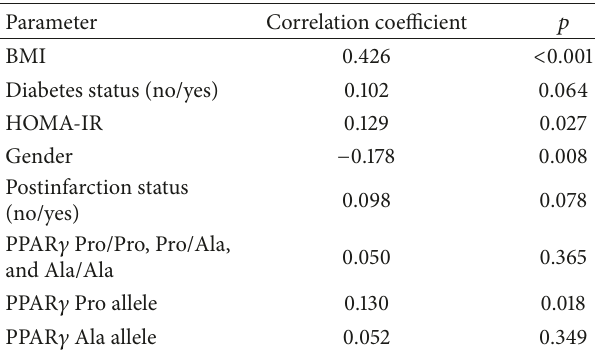
Table 9: Univariate regression analysis between serum fetuin-A concentrations and predictor parameters (𝑛 = 327)